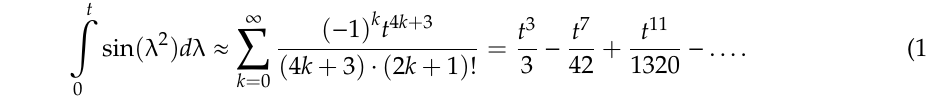
spline series approx. true integral